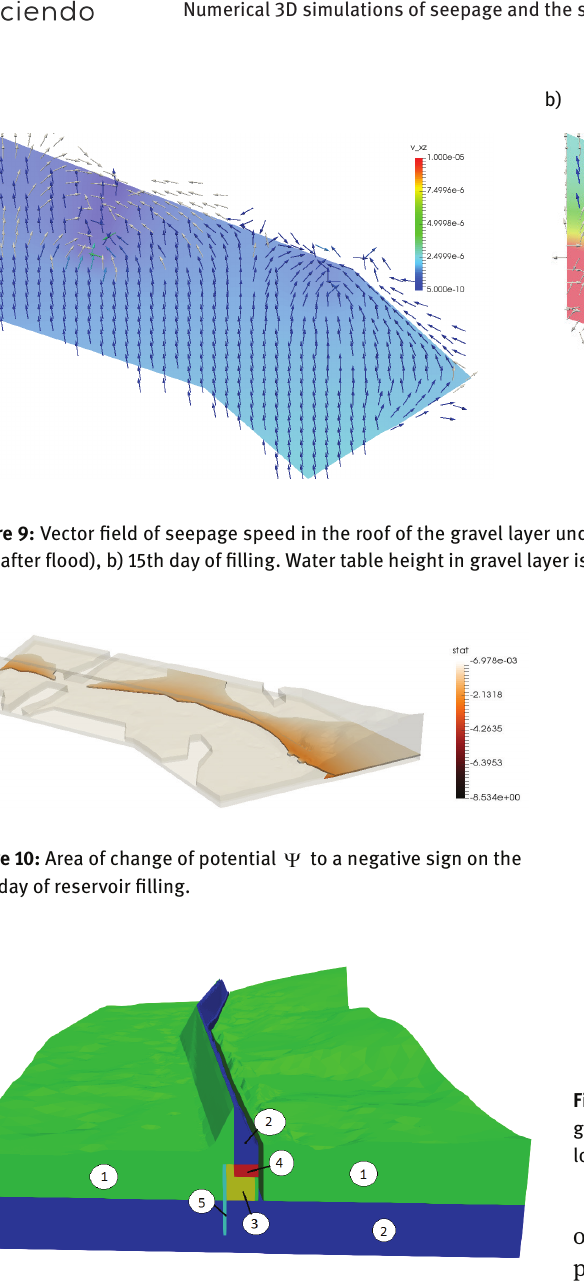
Figure 11: Model geometry (10x exaggeration): 1. clay, 2. gravel, 3. gravel columns in clay, 4. drain, 5. Diaphragm wall